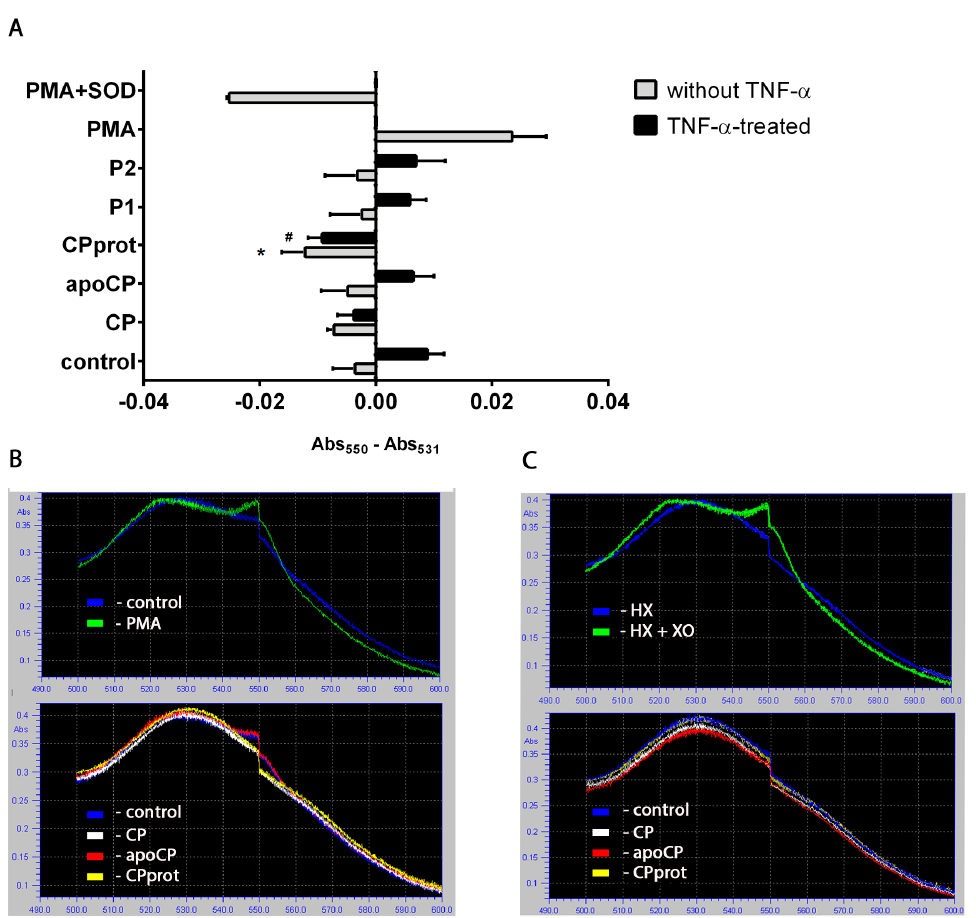
Figure 1. Effects of ceruloplasmin (CP) and its derivatives on superoxide generation by neutrophils and cell-free cytochrome c (Cyto C) reduction. ( A ) Polymorphonuclear leukocytes (PMNLs; 10 6 /mL) were supplemented with Cyto C and cultured with 0.5 µ M CP, 0.5 µ M apo-CP, 0.5 µ M CPprot (proteolyzed ceruloplasmin), or 20 µ M peptides (P1 or P2), with or without 25 ng/mL TNF- α . Phorbol 12-myristate 13-acetate (PMA; 1 nM) and 30 U/mL superoxide dismutase (SOD) were used as positive and negative controls, respectively. Cells were incubated in 24-well plates for 30 min at 37 ◦ C. The rate of Cyto C reduction was measured by the change in differences between absorptions at 550 and 531 nm. Values represent the means ± SEM of ∆ (550/531) of duplicate cultures from six independent experiments; *, # p < 0.05 compared to control (medium) and TNF- α -treated PMNLs, respectively (one-way ANOVA followed by Holm–Š í d á k multiple comparison tests). ( B ) Representative spectra recorded at 600–500 nm of Cyto C reduction in PMNL incubations with apo-CP, CP, CPprot, and PMA. C. Cyto C was incubated with 0.5 µ M CP, 0.5 µ M apo-CP, 0.5 µ M CPprot or with 100 µ M HX + 0.005 U/mL XO following spectra recording as above.